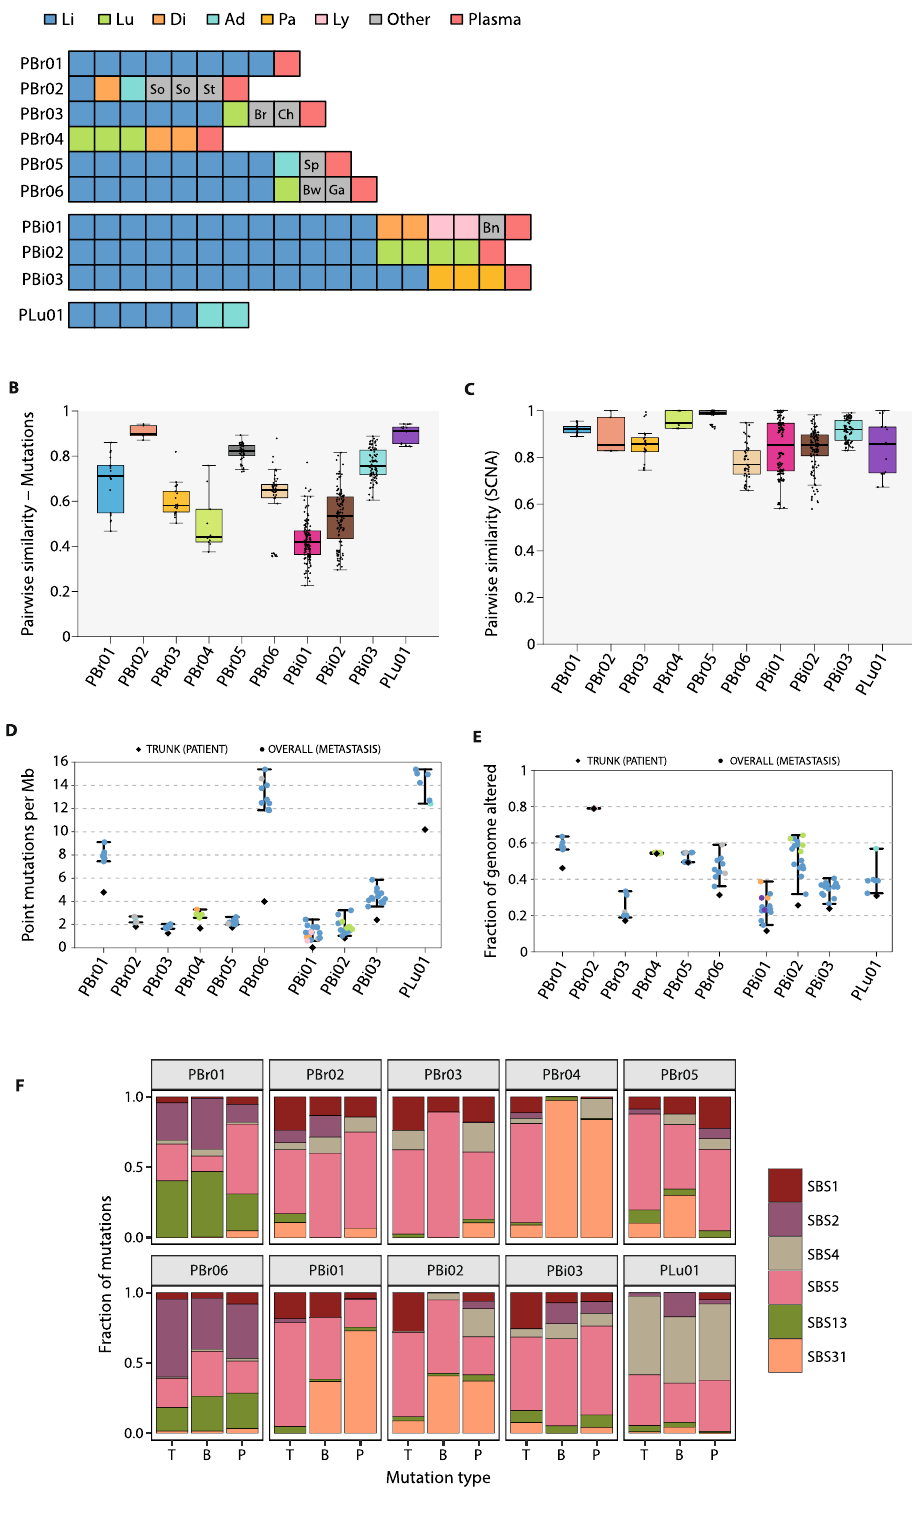
truncal in PBi01. We observed that driver sSNVs were more than four times as likely to be clonal (i.e., found in all cells within a single lesion) than non-driver sSNVs (94.1% of driver sSNVs clonal, 19.9% of non-driver sSNVs clonal; p < 0.001, OR = 4.0). We also identi fi ed mutations associated with resistance to speci fi c therapies in some patients. PBr03 harbored a truncal ESR1 Y537S mutation, which allows for ligand-independent ER